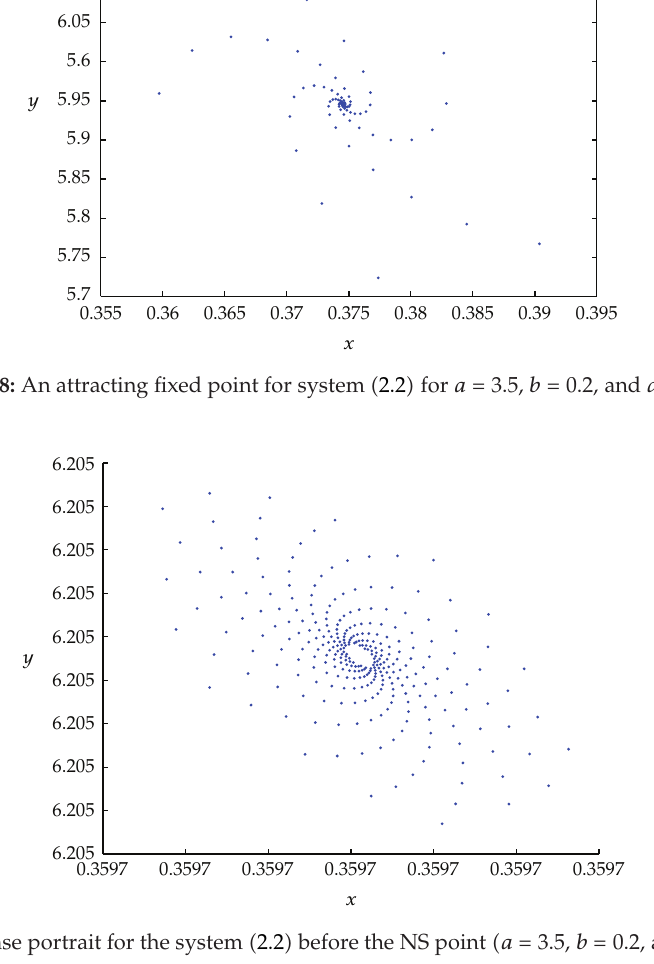
y (cid:8) 12 . 930999111981340, a (cid:8) 5 . 844728289174310, b (cid:8) 0 . 2, and d (cid:8) 2 . 45. We note that the boundary curves contain further bifurcation